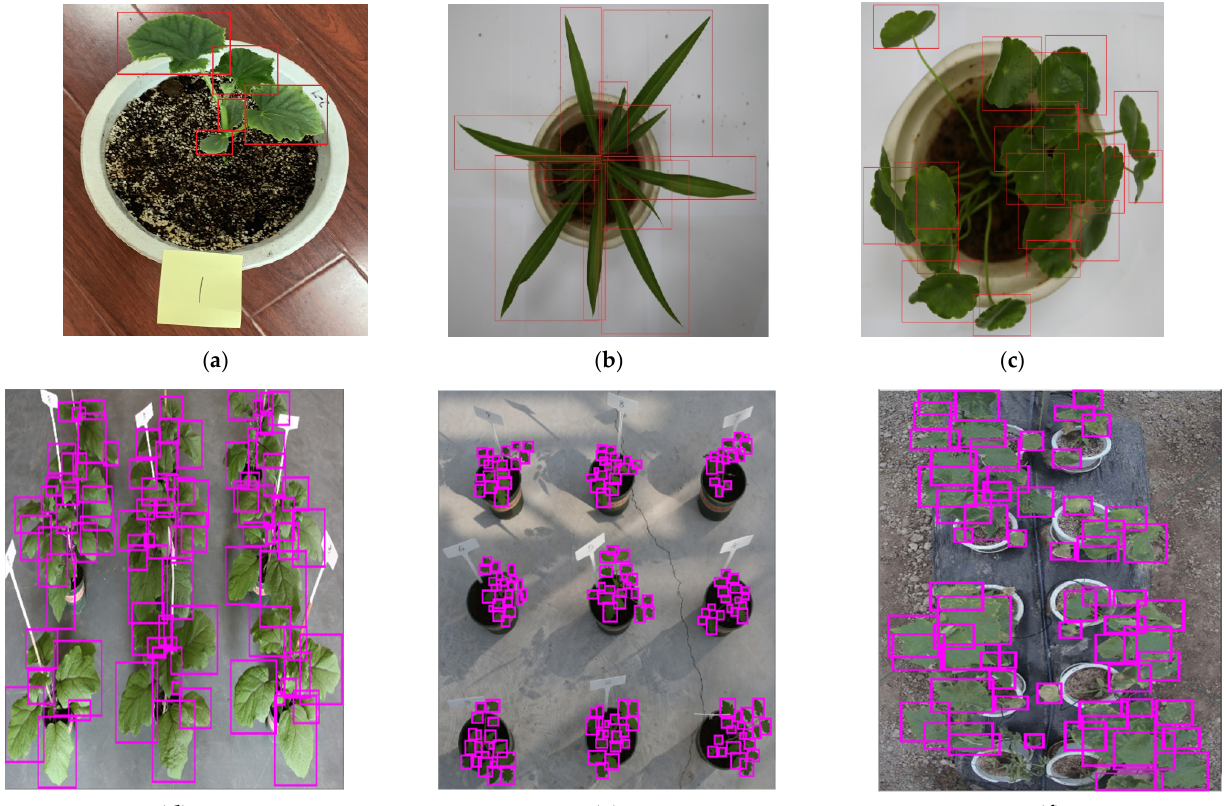
Figure 9. Average detection accuracy for leaves of different plants.